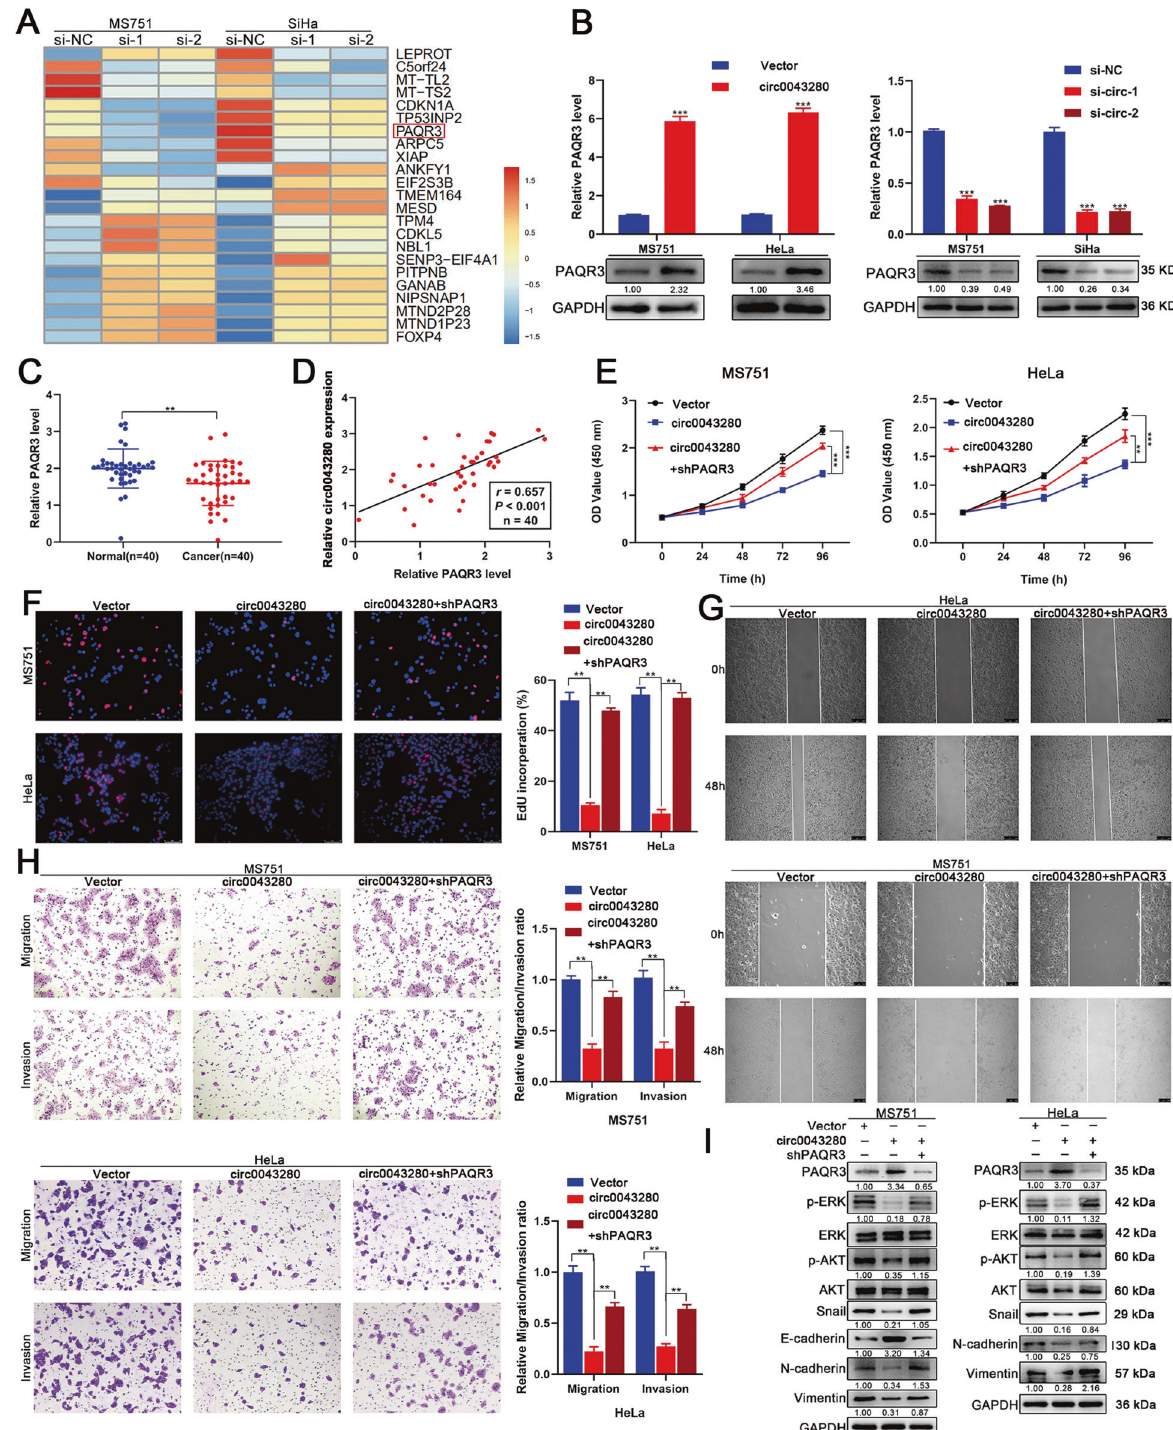
Fig. 4 PAQR3 is a downstream target of hsa_circ_0043280. A RNA-seq analysis revealed the top 23 differentially expressed genes after the depletion of hsa_circ_0043280 in MS751 and SiHa cells. B PAQR3 mRNA and protein expression levels were analyzed by qRT-PCR and western blotting after hsa_circ_0043280 overexpression (left) or ablation (right). C Expression levels of PAQR3 in CCa tissues in comparison with normal tissues, as determined by qRT-PCR. D Scatter plot analysis of the correlation between mRNA expression levels of hsa_circ_0043280 and PAQR3 in 40 fresh cervical cancer tissues. E , F Cell proliferation ability was detected by CCK-8 and EdU assays in the indicated cells. Original magni fi cation, × 100. G Cell migration abilities were measured by wound healing assays in the indicated cells. Original magni fi cation, × 100. H Transwell assays were used to detect the migration and invasion capabilities of the indicated cells. Original magni fi cation, × 100. I Western blot analysis of the protein levels of several EMT markers Snail, E-cadherin, N-cadherin and Vimentin, p-ERK, and p-AKT, in the indicated cells. Each experiment was performed at least three times independently. ** P < 0.01; *** P < 0.001.